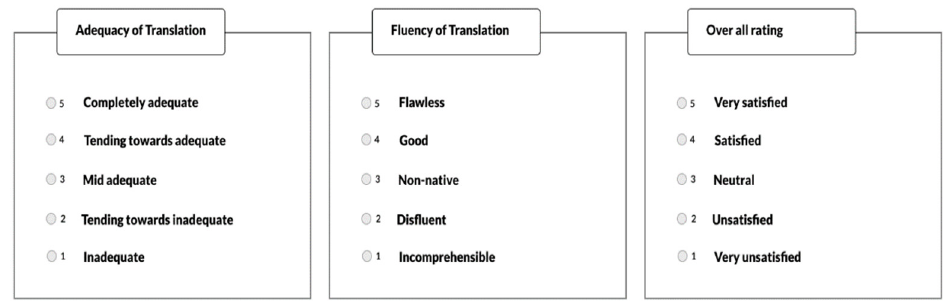
Figure 4. Human assessment scale of adequacy, fluency and overall rating.